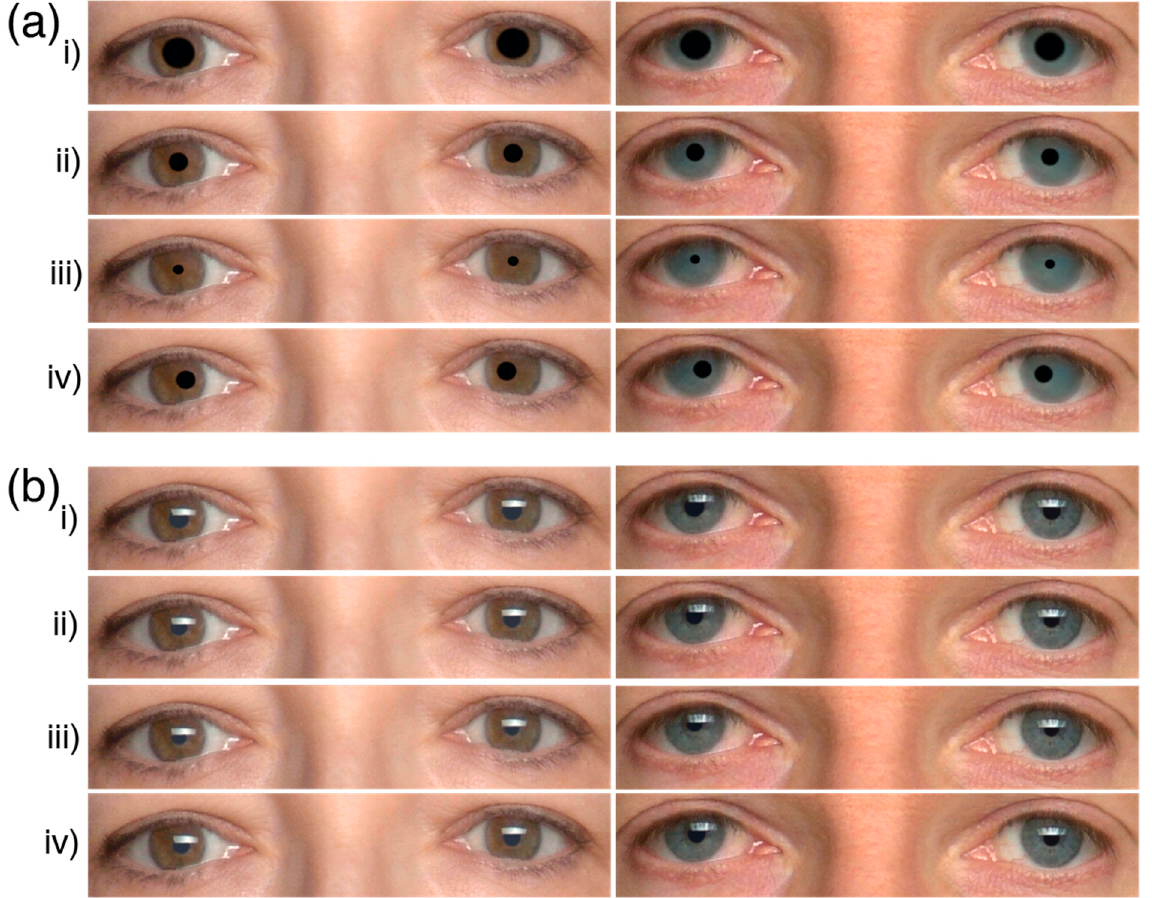
Figure 1. Illustrations of the stimuli used in ( a ) Experiment 1 and ( b ) Experiment 2. The eyes were 1140 × 226 pixels in dimensions. The pupils were (i) big, (ii) medium, (iii) small, and (iv) vergence. The pupils in ( a ) have the same area across all eye models. The pupils in ( b ) have different areas based on the eye models. The models in this illustration were models #29 and #70 from the FACES database.